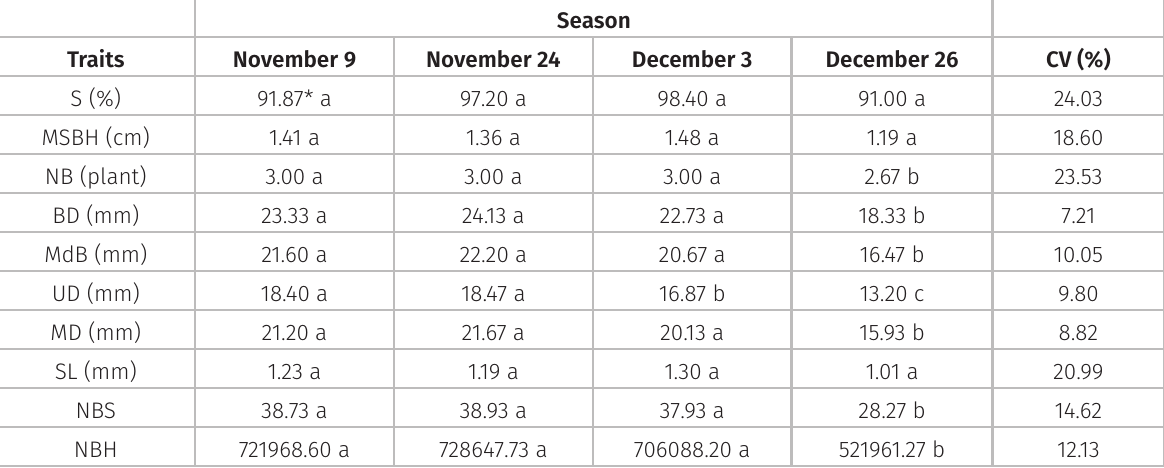
Table I. Percentage of survival (S%), main stem branching height (MSBH), number of branches (NB), stem base diameter (BD), stem middle diameter (MdD), stem upper diameter (UD), mean stem diameter (MD), stem length (SL), number of buds per stem (NBS), and number of buds per hectare (NBH) of cassava plants transplanted on November 9 and 24 and December 3 and